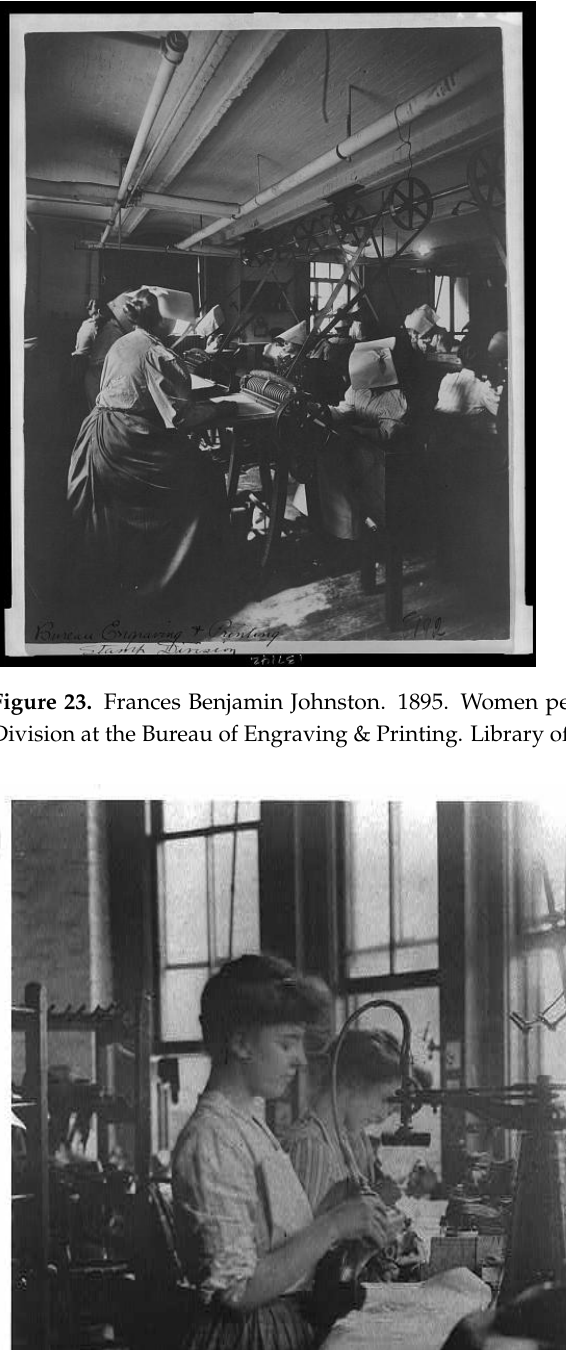
Figure 22. Frances Benjamin Johnston. 1895–1910. Bureau of Engraving & Printing—stamp division. Library of Congress.